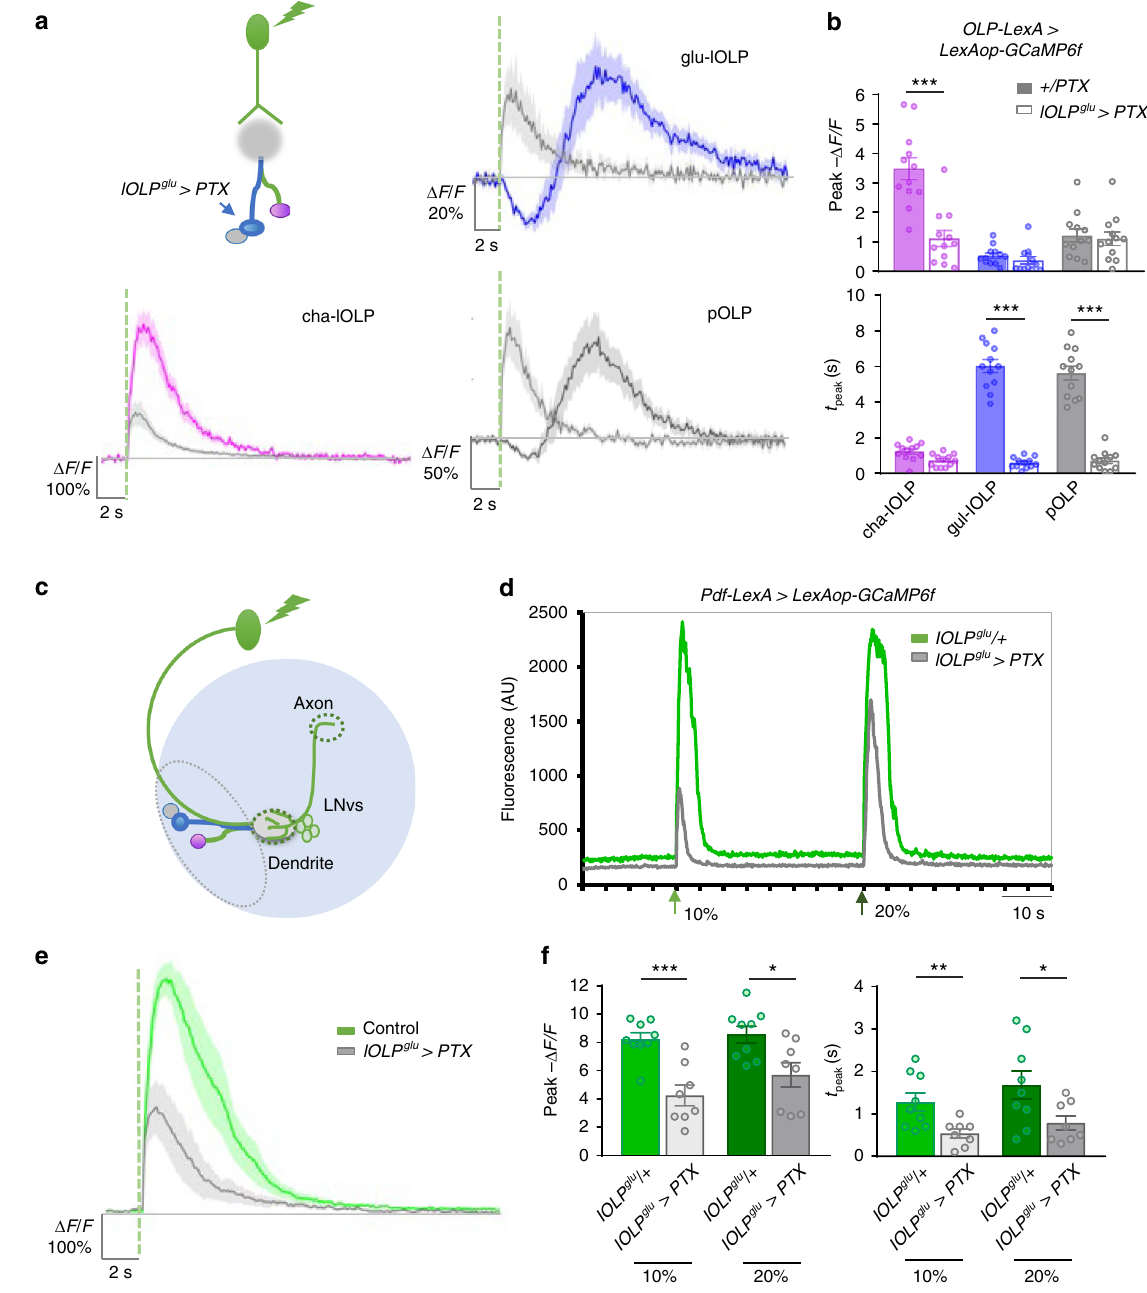
Fig. 6 Glu-lOLP regulates light responses in cha-lOLP, pOLP, and LNvs. a , b glu-lOLP inhibits cha-lOLP and activates pOLP. a Schematic diagram illustrating the experimental design, with PTX expression restricted to glu-lOLP while light responses in the three OLPs are reported by OLP-LexA-driven LexAop- GCaMP6f. PTX expression accelerates glu-lOLP ’ s and pOLP ’ s activations and dampens the response in cha-lOLP. Average traces of changes in GCaMP signals are shown. The dashed green line represents a 100 ms light pulse at 561 nm. Shaded areas on traces represent SEM. b Quanti fi cations of the peak value and peak time of changed intensity ( Δ F / F ) of GCaMP6f are shown. n = 12 in all groups. Peak values — cha-lOLP: p < 0.001; glu-OLP: p = 0.9967; pOLP: p = 0.9995. Peak times: cha-lOLP: p = 0.6956; glu-lOLP: p < 0.001; pOLP: p < 0.001. Error bars represent SEM. Statistical signi fi cance was determined by one-way ANOVA with post hoc Tukey ’ s multiple comparison ’ s test. c Schematic diagram showing the optical recording of light-induced responses in LNvs. Pdf-LexA-driven GCaMP6f signals are recorded in the axon terminal region (dashed circle). d A representative raw trace is shown. 100 ms light stimulations (green arrows) were delivered with either 10% or 20% laser power and induced robust calcium increases in LNvs. Compared to the controls, PTX expression in glu-lOLP (lOLP glu > PTX) leads to dampened responses with reduced durations. e , f PTX expression in glu-lOLP reduced the light-induced calcium response in LNvs. Average traces ( e ) and quanti fi cations ( f ) of the peak valu e (left) and peak time (right) of changed intensity ( Δ F / F ) of GCaMP6f signals are shown. The dashed green line represents a 100 ms light stimulation at 10% intensity. Two different intensities of light stimulation generated similar results. Control: n = 9; lOLP glu > PTX: n = 8. Peak values: 10%: p = 0.0003, t = 4.758, df = 15; 20%: p = 0.0136, t = 2.795, df = 15. Peak times: 10%: p = 0.0090, t = 2.998, df = 15; 20%: p = 0.0354, t = 2.311, df = 15. Statistical signi fi cance was determined by Student ’ s t test. * p < 0.05, ** p < 0.01, and *** p <